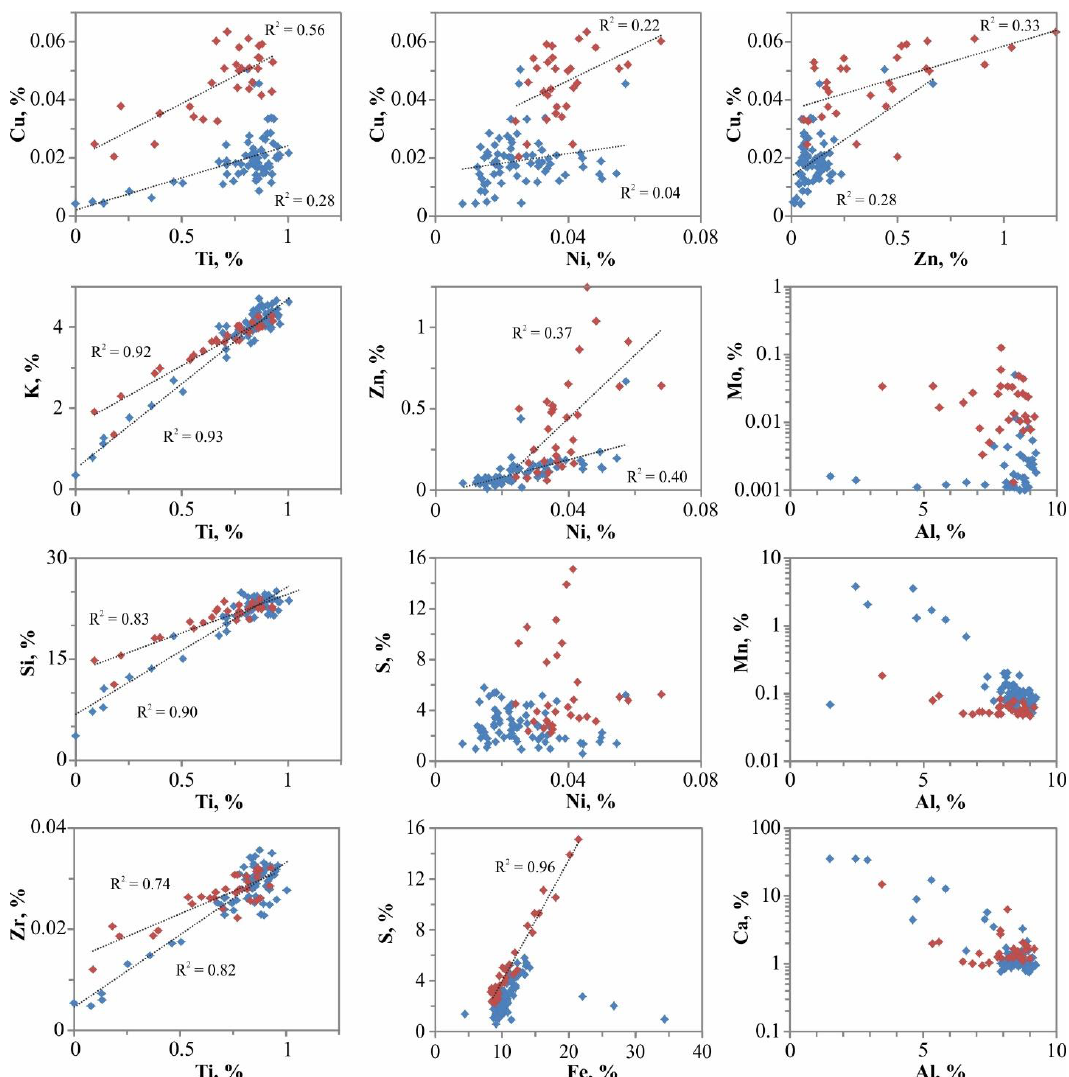
Figure A3. Cross-plots of element content in rocks. The two series of samples represent deposits of different genesis: terrigenous with the increased role of biogenic sedimentation (members #3, #4, #5, and #7, red markers) and predominantly terrigenous sedimentation (members #1, #2, #6, and #8, blue markers). The correlations are drawn where found, and correlation factor is given (R 2 ).